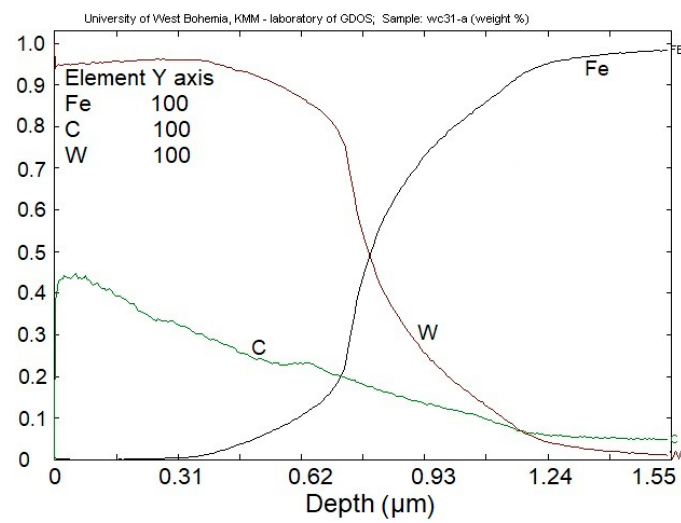
Figure 6. Cross-sectional chemical profiles of WC/C coating deposited with Ar.